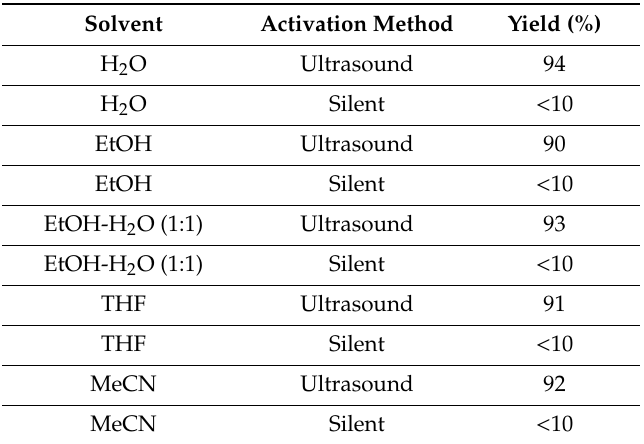
Table 1. Determination of the reaction conditions for the synthesis of rhodanine derivatives using model reagents 1 . Adapted from Rostamnia and Lamei